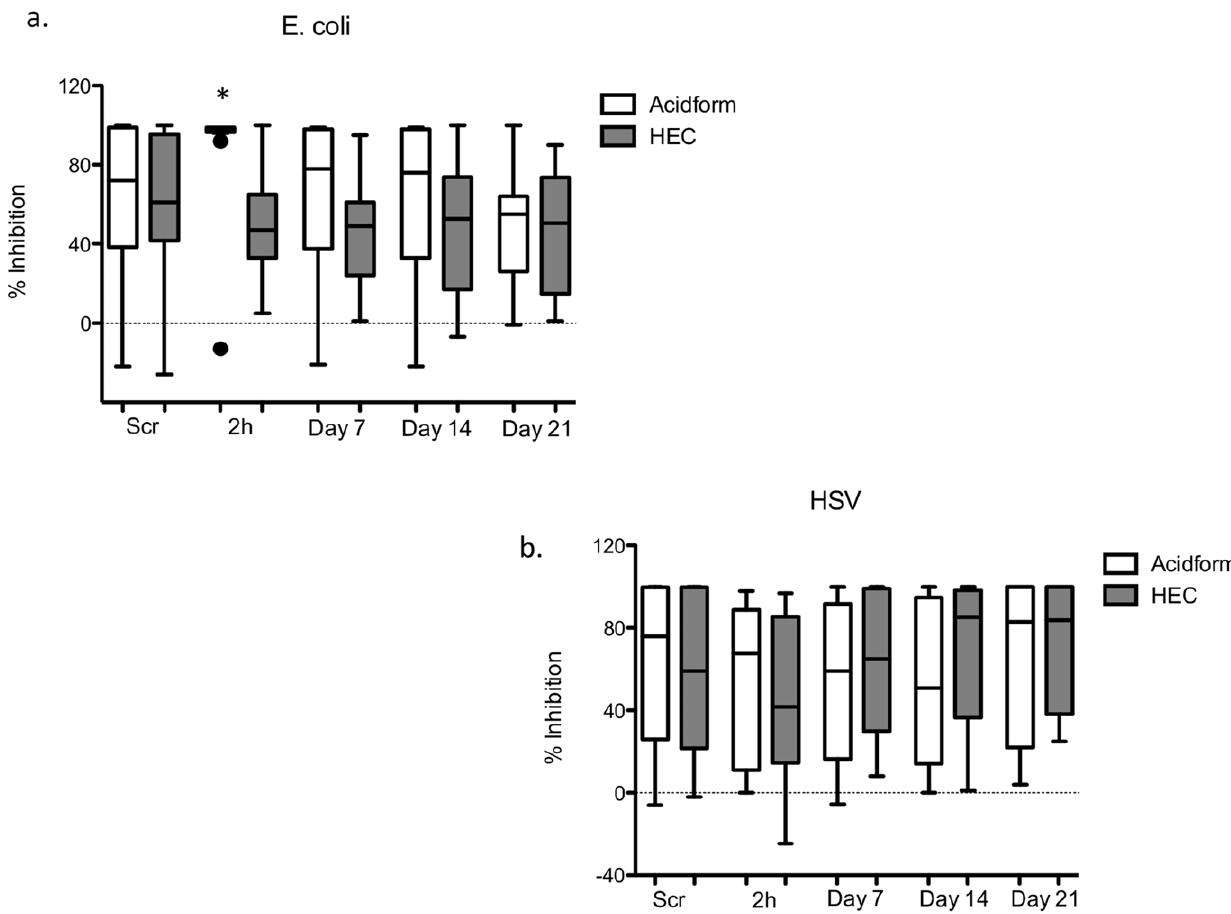
Figure 3. The bactericidal activity of genital tract secretions against E.coli was significantly greater 2 hours after application of Acidform compared to HEC placebo gel. Box-and-whisker plots showing the percent inhibition of E. coli (a) and HSV-2 plaque formation (b) in CVL samples collected at screening (Scr), 2 hours (2 h) and at Days 7, 14 and 21 after insertion of Acidform (white) or HEC placebo gel (gray). The line indicates the median values and the circles are outliers. The asterisk denotes a significant difference between the Acidform and HEC placebo